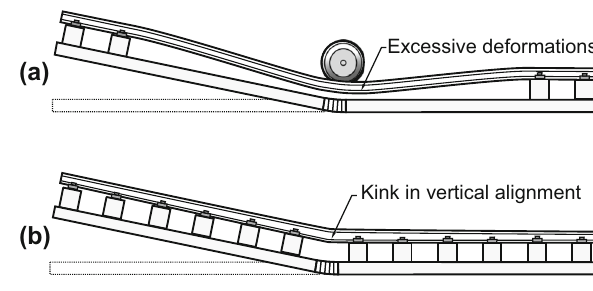
Fig. 3 Track bending and support requirements, ( a ) rail is allowed to bend over a long free length, ( b ) rail is fully supported across the